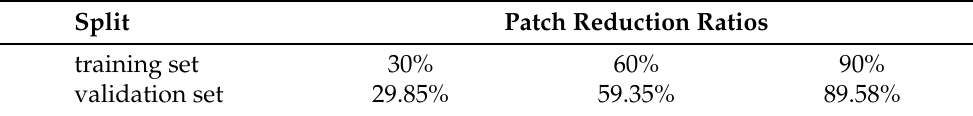
) for each patch of 1000 videos extracted from the HMDB- Figure 4. Histograms of information I ( x P ( k ) ) for the training and validation 51 training and validation sets. The distributions of information I ( x P ( k ) sets are very close. Table 1. The patch reduction ratios in the validation set (1000 videos) by the thresholds, which are determined to achieve specific patch reduction ratios in the training set (1000 videos) on